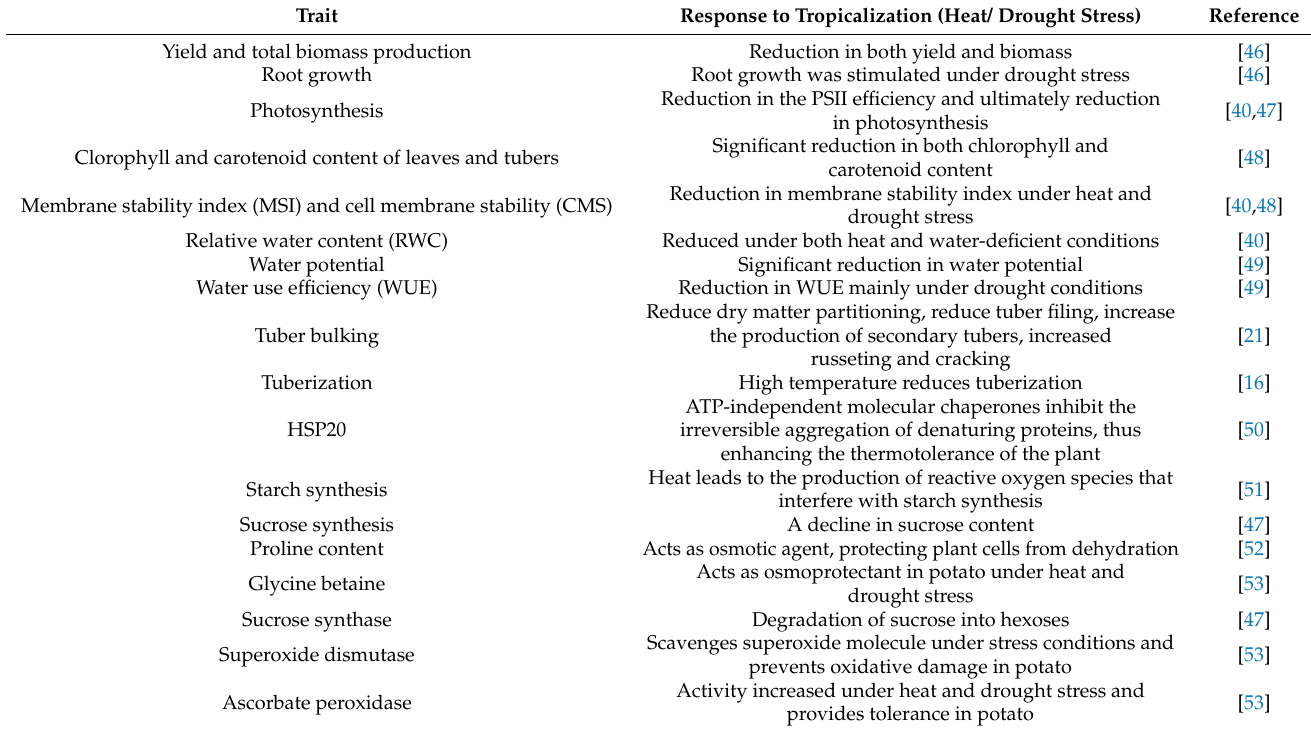
Table 1. Physiological and biochemical responses of potato under heat/drought